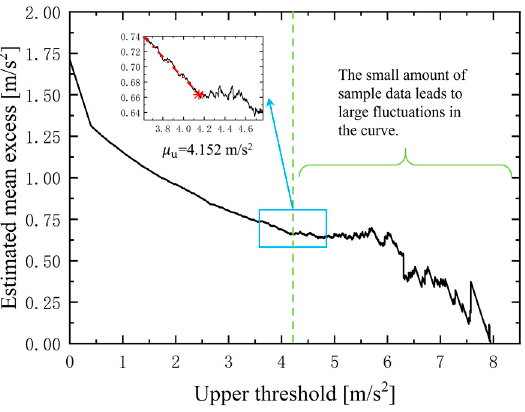
Figure 13. The MEF diagram of the excess of the upper limit threshold of the ploughing ground load.